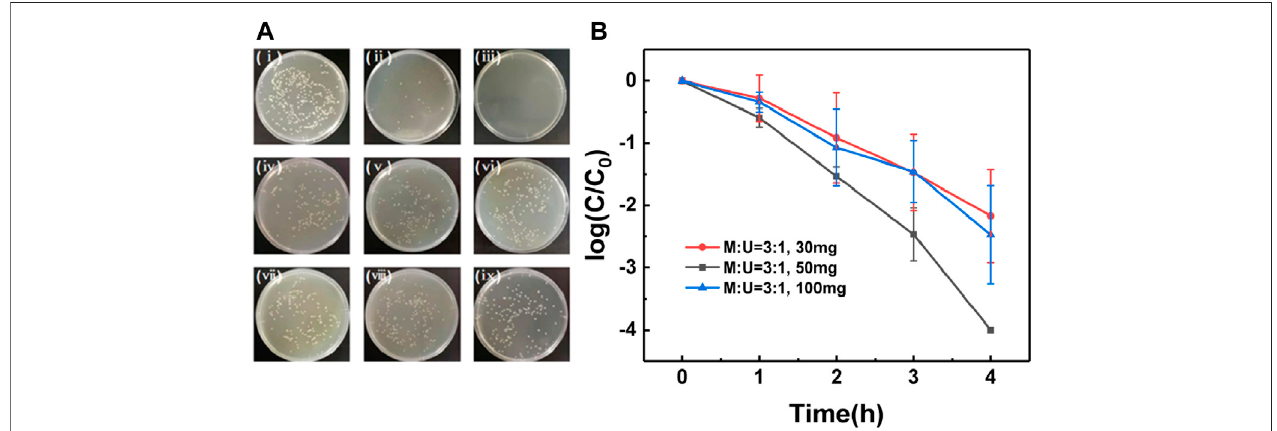
FIGURE3|(A) Photosof E.coli onplate countagarsspreadbeforeandafter photocatalyticdisinfectionusingg-C 3 N 4 fi lm:undervisiblelightirradiationfor( ⅰ )0h( ⅱ ) 2 hand( ⅲ )4 h.Photosof E.coli onanagarplatebeforeandafterphotocatalyticdisinfectionwithoutg-C 3 N 4 fi lm:undervisiblelightirradiationfor( ⅳ )0h( ⅴ )2 hand( ⅵ )4 h. Photosof E.coli onanagarplatebeforeandafterphotocatalyticdisinfectionwithoutvisiblelightirradiation( ⅶ )0h,( ⅷ )2 hand( ⅸ )4 h. (B) Comparisonofthedisinfection performance of g-C 3 N 4 fi lm with control